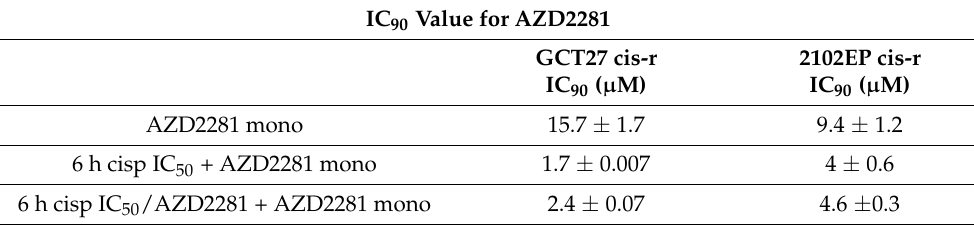
Table 3. IC 90 of AZD2281 in monotherapy (mono) (top row), in combined sequential (cis- platin>AZD2281) monotherapies (middle row) and combined therapy with concomitant adminis- tration of cisplatin and AZD2281, followed by AZD2281 monotherapy (bottom row). In all cases, cisplatin (cisp) concentration was equal to the IC 50 value. IC 90 Value for AZD2281 GCT27 cis-r 2102EP cis-r IC 90 ( µ M) IC 90 ( µ M) AZD2281 mono